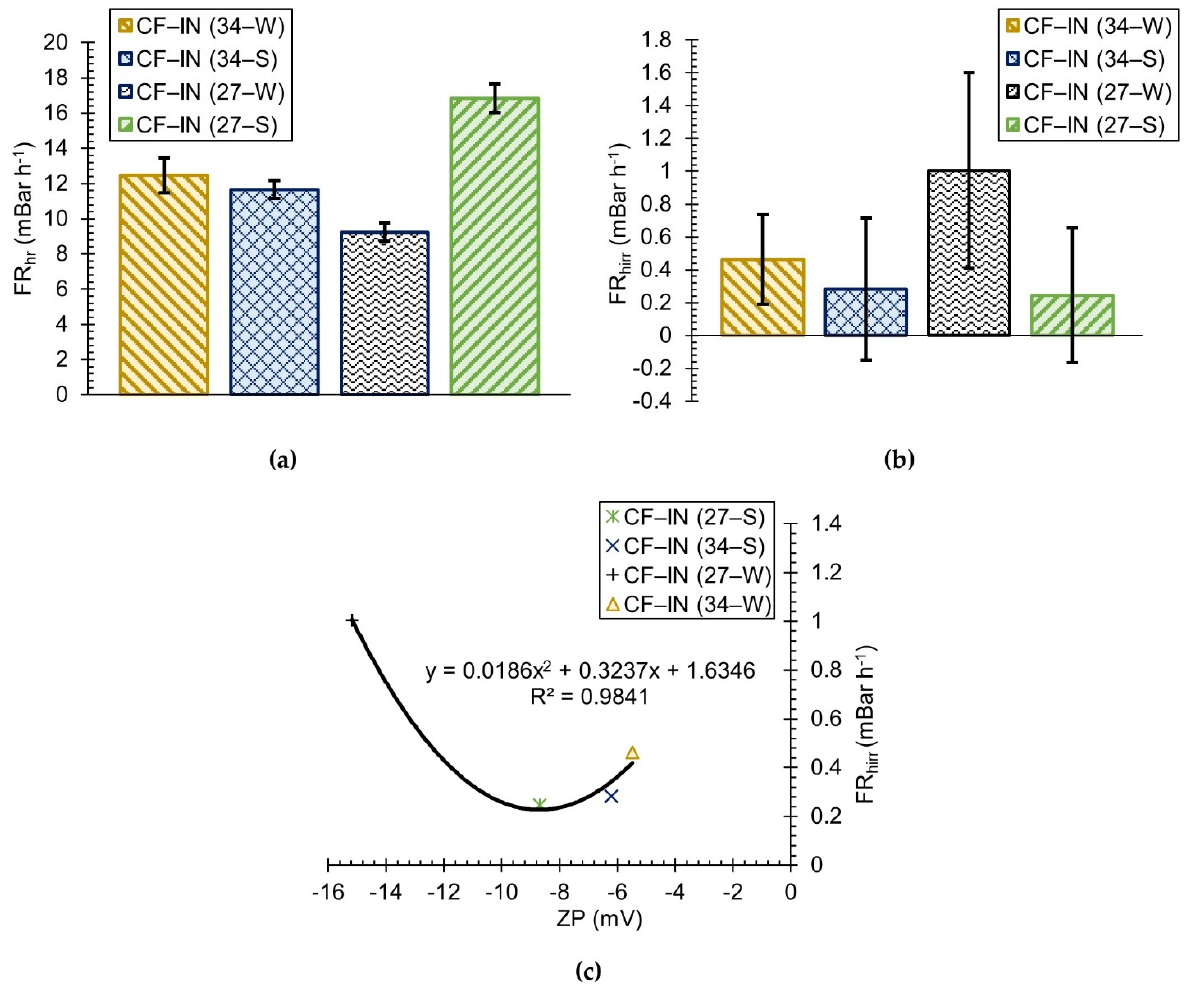
Figure 5. Comparison of seasonal CF–IN fouling rates: ( a ) hydraulically reversible; ( b ) hydraulically irreversible; ( c ) relationship between ZP and hydraulically irreversible.